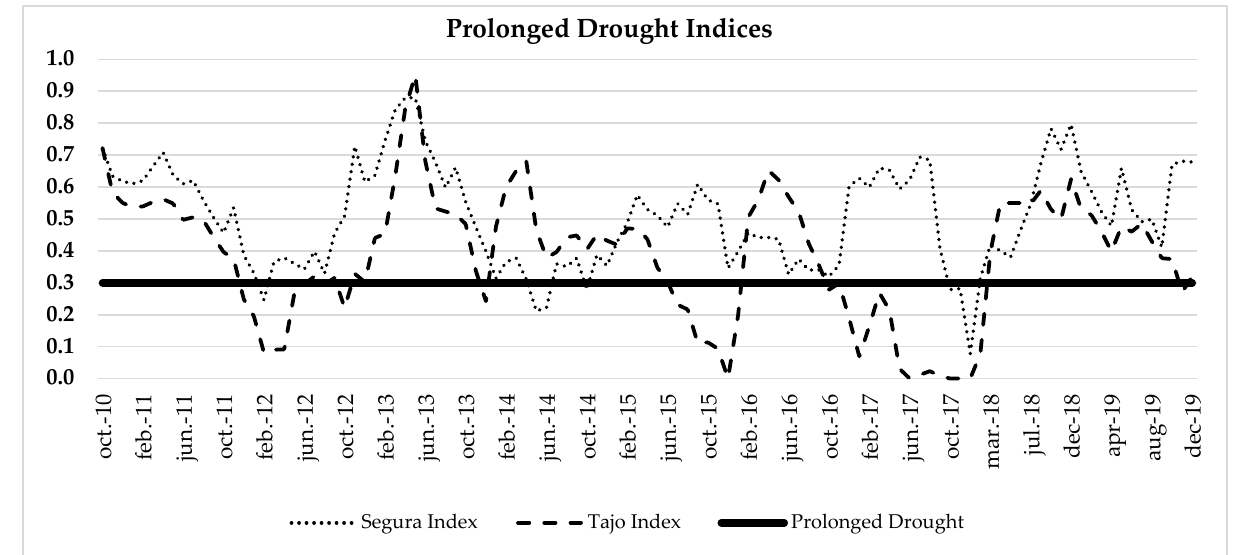
Figure 9. Evolution of the Prolonged Drought Indices of the Segura Basin and the headwaters of the Tajo Basin, period October 2010–December 2019. Source: own elaboration based on [64]. With respect to the indices of temporary scarcity, the SDP 2018 establishes that for the TUS of the headwaters and the left and right tributaries, the scarcity indices are also the 9-month SPIs. In contrast, the Principal TUS System Index, considered as the Global Index for the whole basin, is established as the average of the indices of the own resources of the basin and the resources of the Tajo-Segura transfer. The three temporary scarcity indices, according to the methodology of the SDP 2018, are graphically represented in the following figures. The first graph (Figure 10) shows the evolution of the index of the basin resources, which displays a decreasing trend from March 2014 (value of 0.972). The pre-alert level was reached in July 2016, the alert level in June 2017 and the emergency level in the period between October 2017 and March 2018. Finally, we should point out that on the 1st of May 2015, the date when the drought was declared, the Status Index of the basin was in a situ- ation of normality.